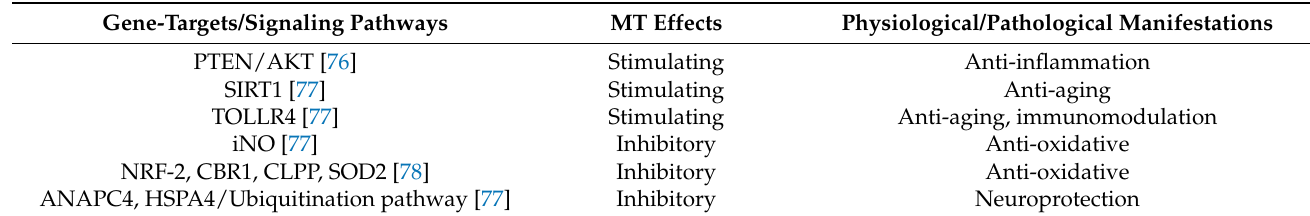
Table 1. Examples of key genes and signaling pathways mediating the effects of